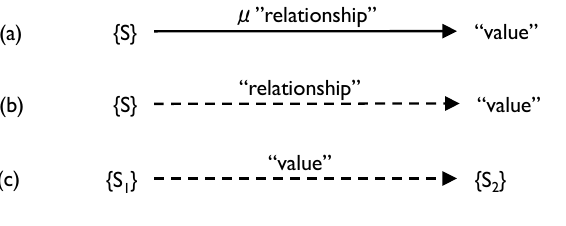
Figure A1. Process connections.